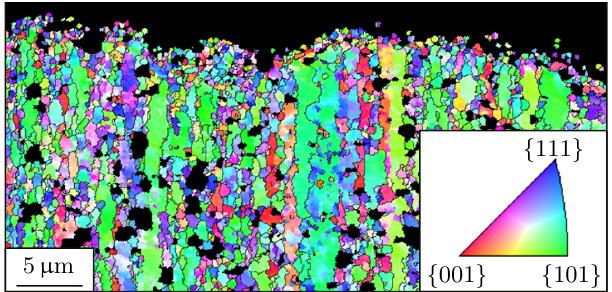
Figure 18. Microstructure of the surface layer for a 5 ◦ rake angle of the minor cutting edge ( v c =250m/min, f z =0.015mm, a p =0.25mm, a e =0.5mm, α (cid:48) o = 2 ◦